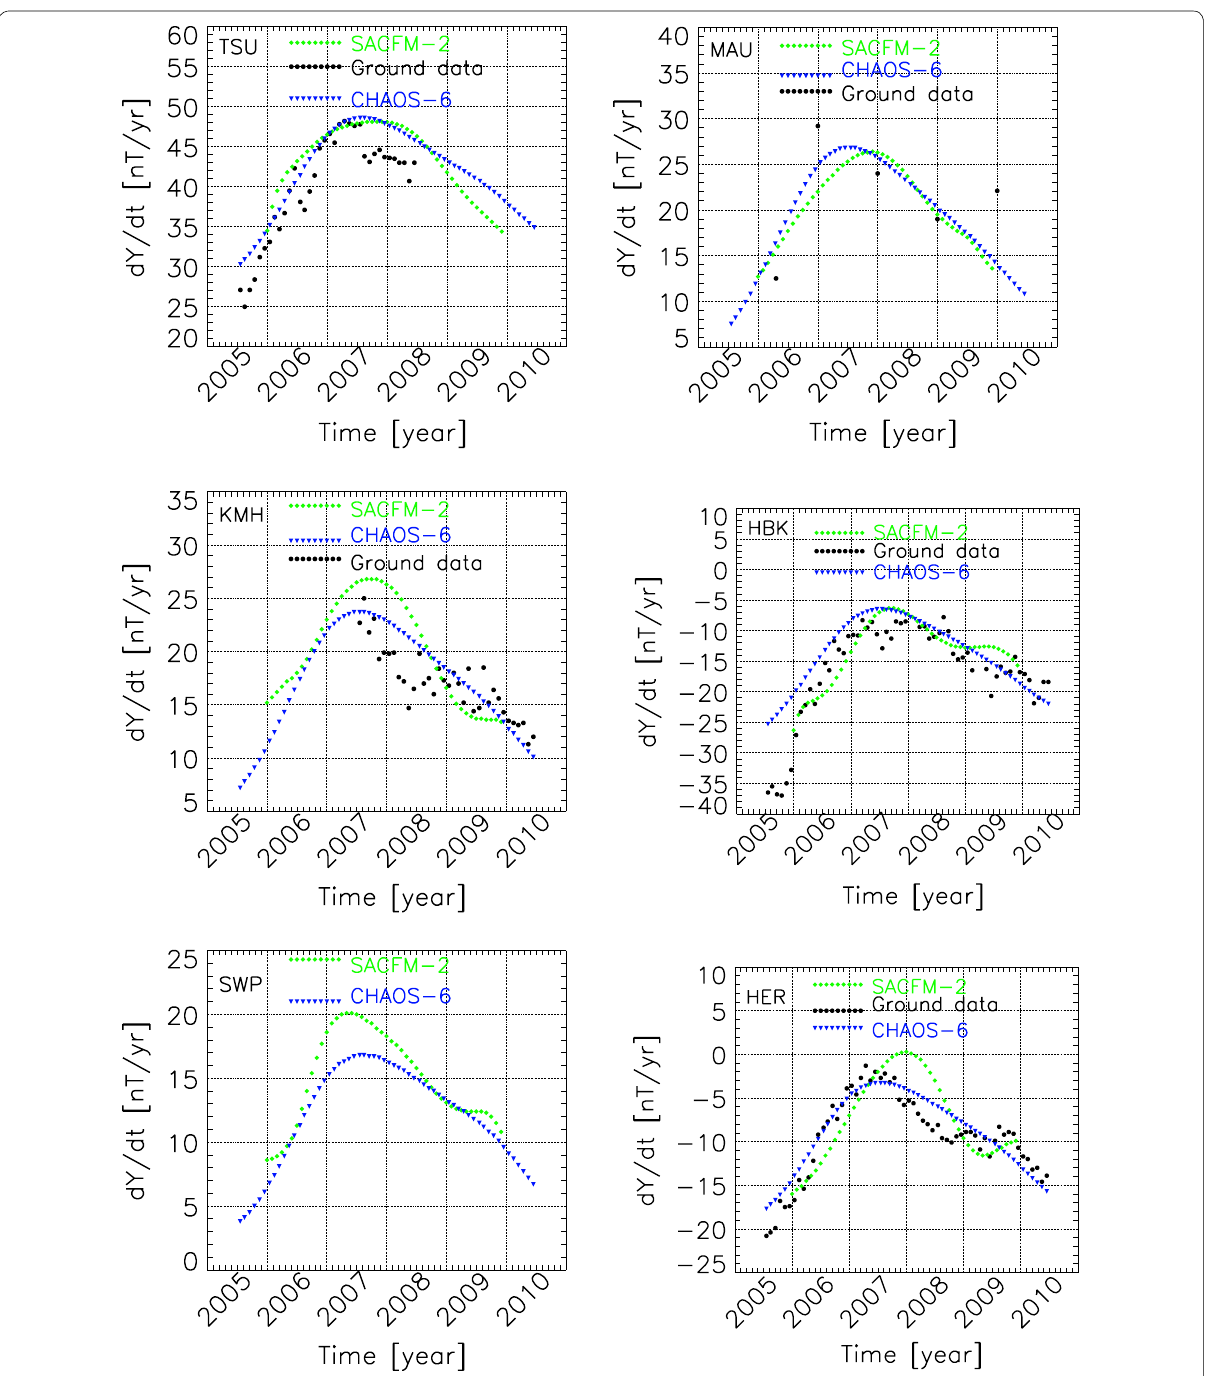
Fig. 6 Secular variation at TSU, KMH, MAU, SWP and HER for Y component. Secular variation of the Y component at the four observatories (data in black) and two additional reference points between 2005 and 2010 as given by SACFM-2 (green) and CHAOS-6 (blue)